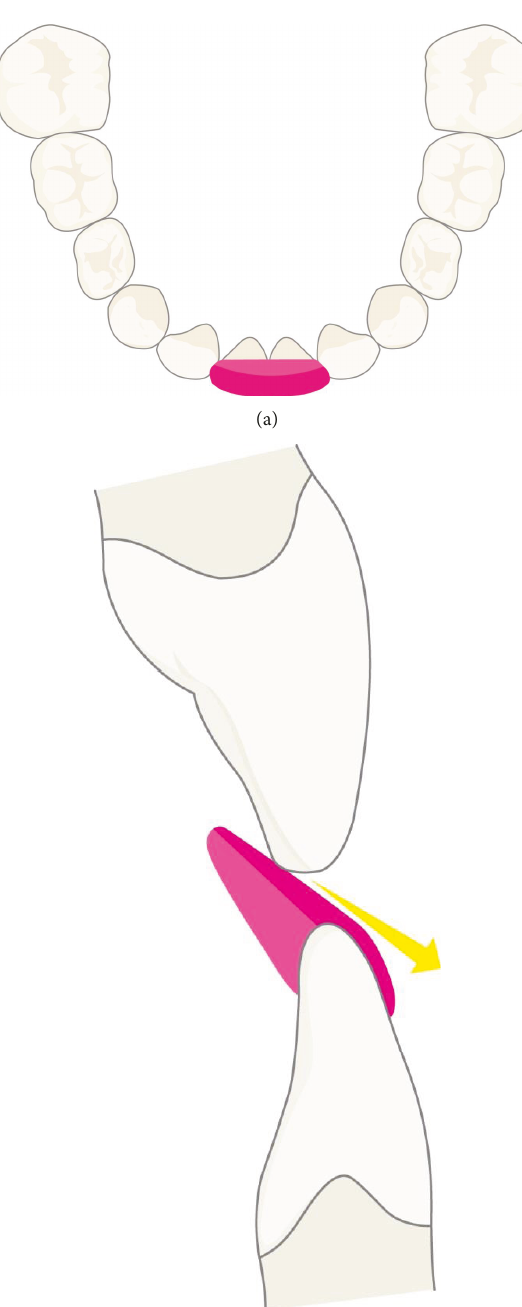
Figure 1: (a) Illustration of the functional turbo (pink) from the occlusal. (b) Illustration of the functional turbo from the sagittal. The turbo nudges the maxillary incisor forward and the mandible